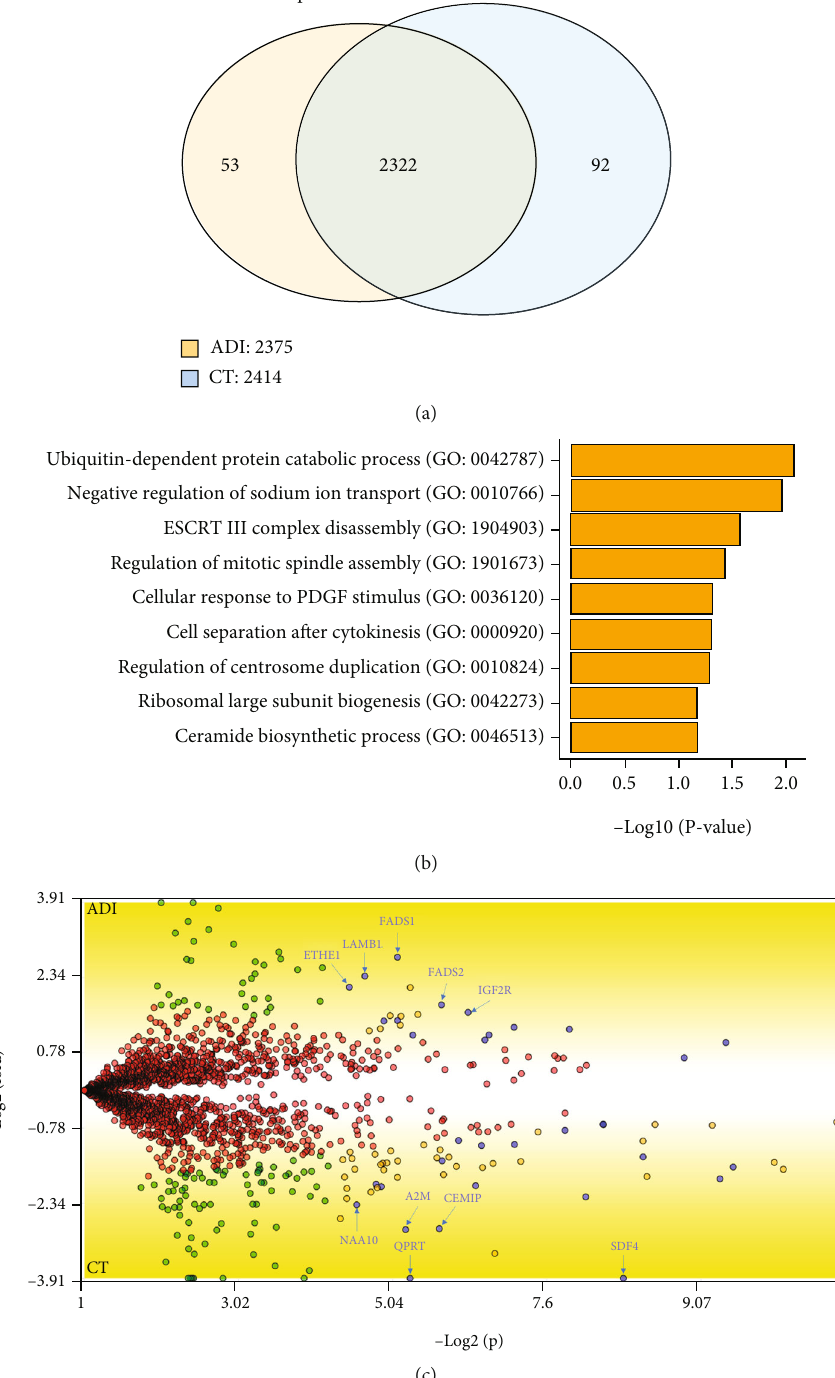
Figure 2: Proteins identi fi ed in 24 h-di ff erentiated and undi ff erentiated hASC. (a) A total of 3420 proteins were identi fi ed. The Venn diagram shows that 2322 proteins are common to 24h-di ff erentiated (ADI) and undi ff erentiated hASC (CT) conditions. Cells exposed to 24 hours of adipogenic cocktail have 53 exclusive proteins. Undi ff erentiated hASC have 92 exclusive proteins. ∗ The Venn diagram represents the number of proteins that satisfy a minimum of 2 replicates. (b) Gene Ontology analysis of the 53 uniquely identi fi ed proteins after adipogenic induction. Only biological processes with P ≤ 0 : 05 are shown. (c) Di ff erently abundant proteins identi fi ed in hASC exposed to 24 hours of adipogenic di ff erentiation. Blue dots represent the 33 proteins that satisfy our stringent criteria. Red dots represent proteins with no satisfying fold change cuto ff and established FDR. Green dots represent proteins that satisfy only the fold change cuto ff . Orange dots represent proteins that satisfy both criteria but received very low quantitative values. The fi ve proteins with the highest and lowest abundance are